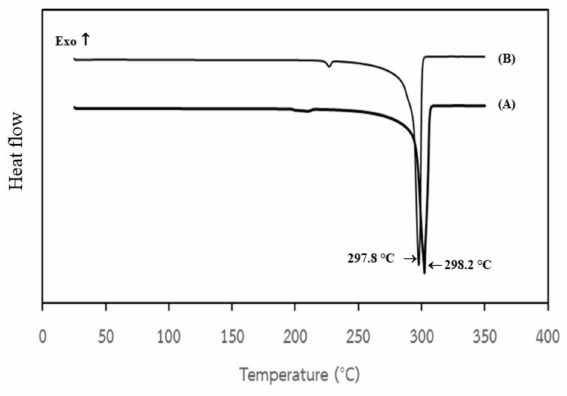
Figure 4. DSC scans of (A) commercial fumaric acid (FA) and (B) bio-synthesized